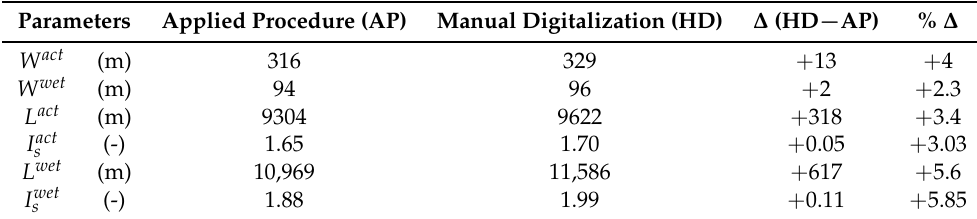
Table 5. Comparison between the outputs of the applied procedure and values from manual digitalization, Vjosë